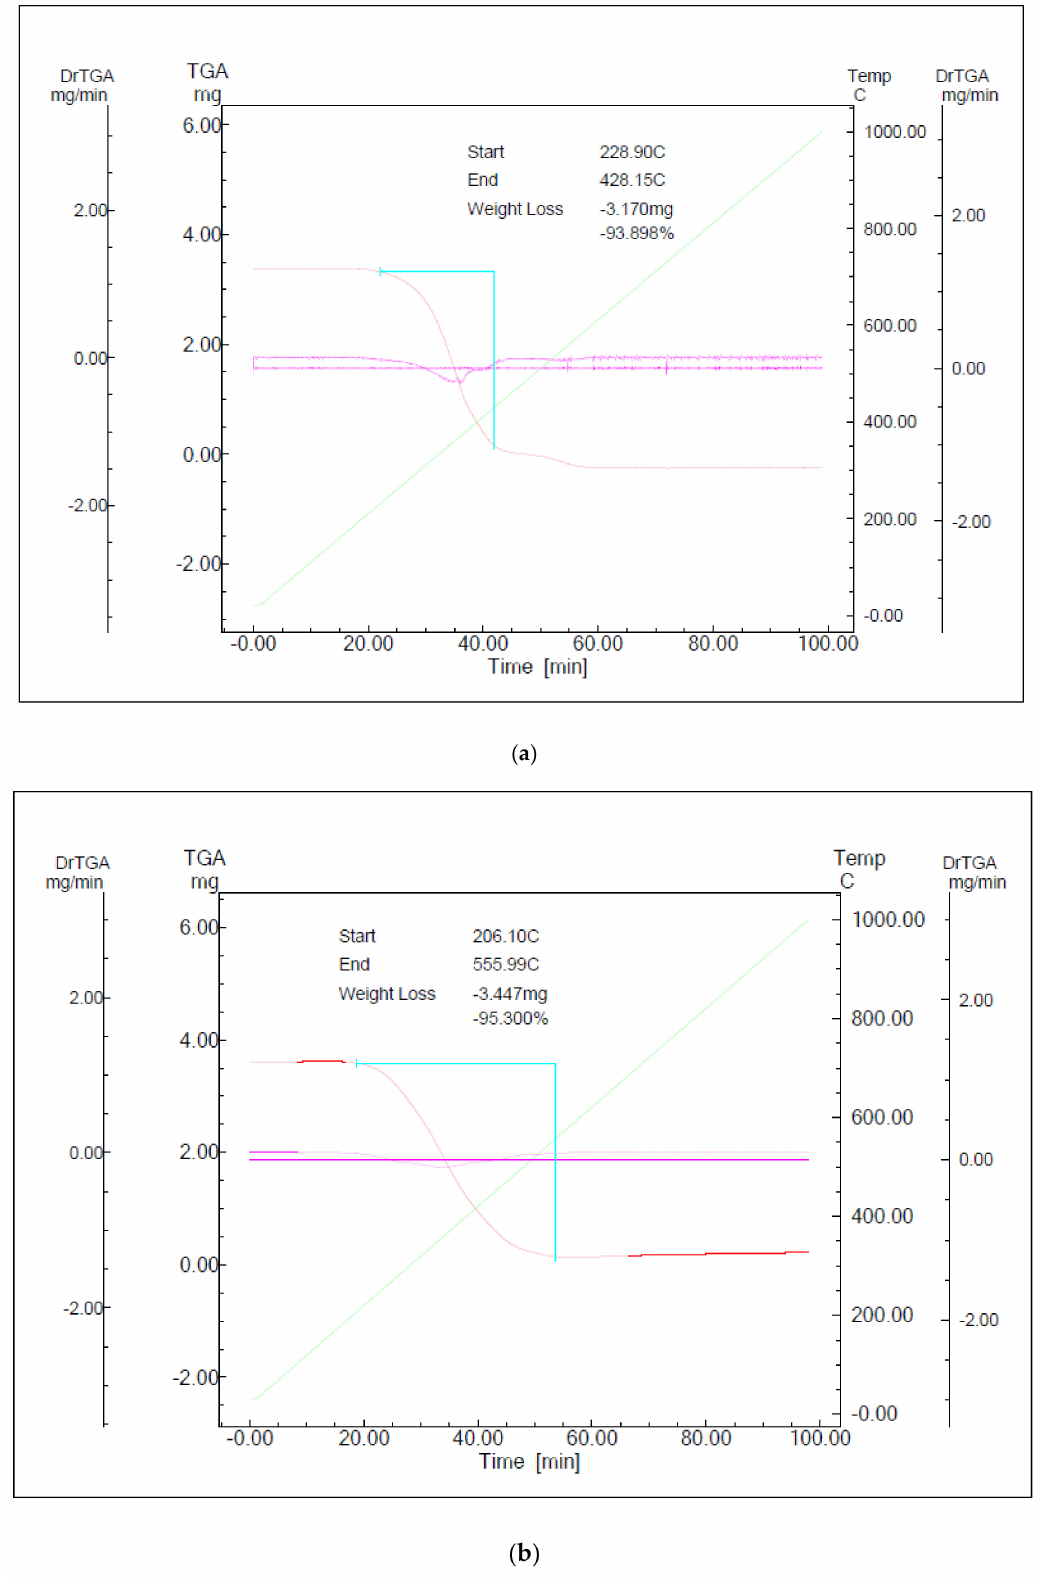
Figure A11. TGA Sample AA-75T-25M ( a ) Nitrogen atmosphere ( b ) air